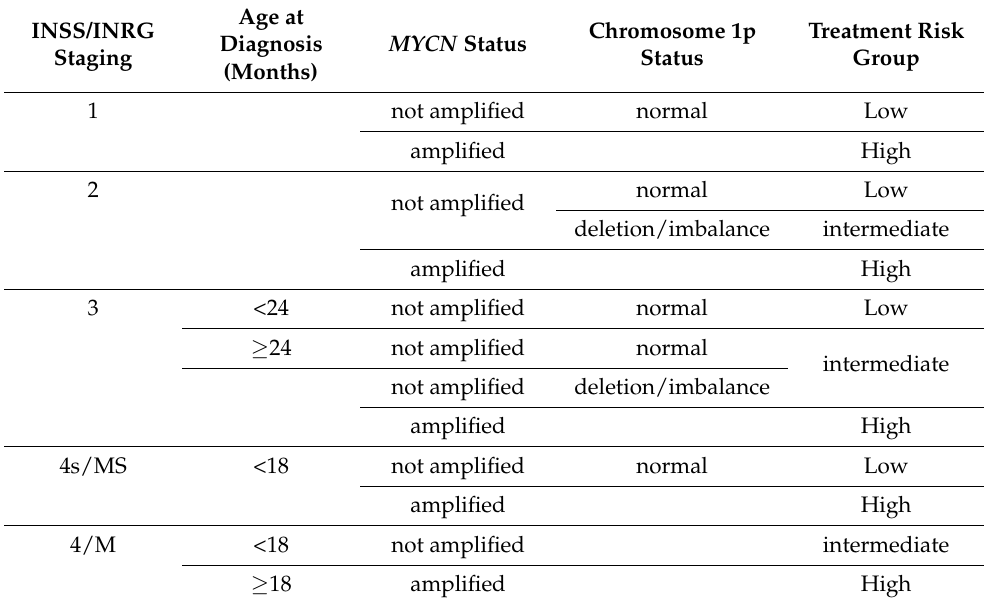
Table 1. Treatment classification of neuroblastoma